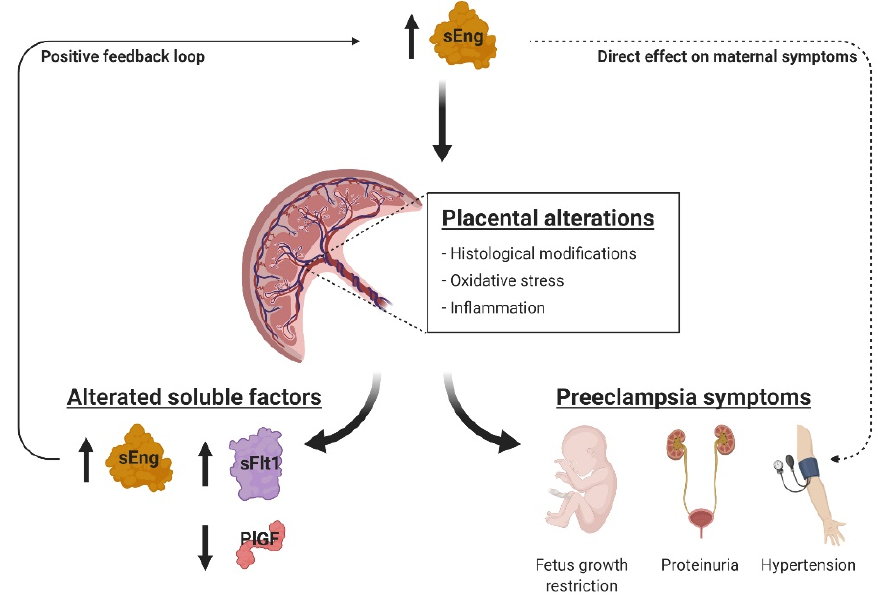
Figure 6. Hypothetical model of sEng role in preeclampsia. The high levels of soluble endoglin (sEng) are directly involved in the appearance of maternal preeclampsia symptoms, such as hypertension or proteinuria (dashed arrowhead on the right), as shown in non-pregnant animal models. But during pregnancy, sEng can also induce placental alterations such as inflammation, oxidative stress, and hypoxia. These alterations seem to be due to a defective pseudovasculogenesis and a diminished proliferative and invasive capacity of trophoblasts, and lead to the appearance of maternal symptoms, as well as the abnormal levels of soluble factors. As sEng is one of these factors whose expression is increased, it could trigger a positive feedback loop that may contribute to aggravate the disease (continuous arrowhead on the left). Created with